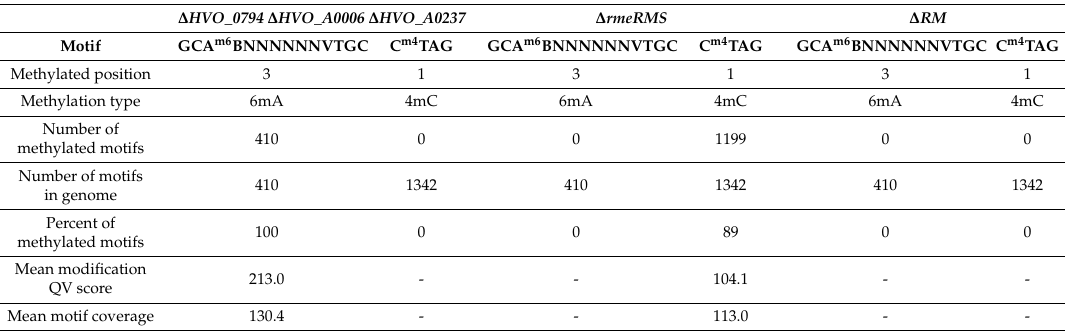
Table 5. DNA methylation patterns detected in H. volcanii RM deletion